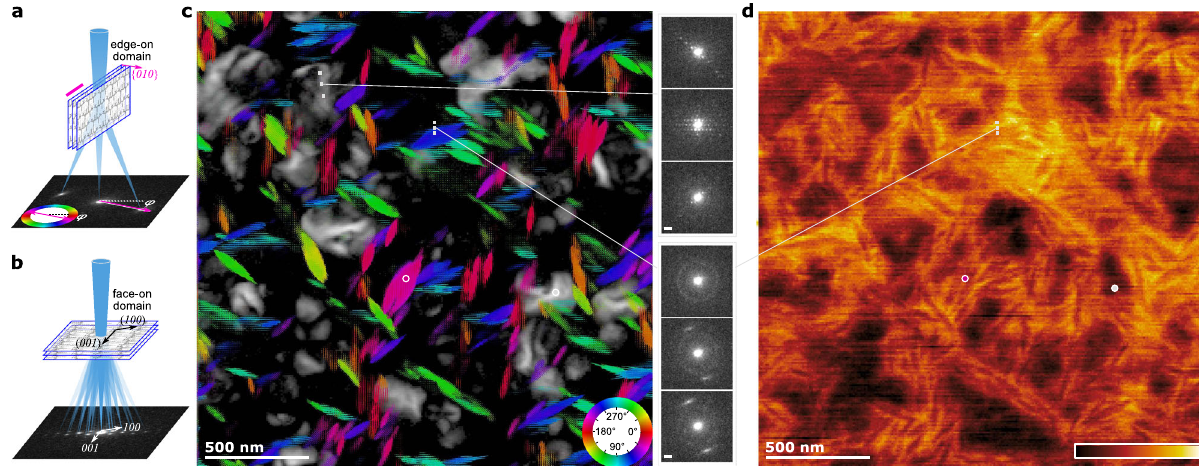
Fig. 4 Visualization of the orientation of donor nano-crystallites and distribution of acceptor. Scheme a uses a color wheel method to encode the edge- on domain orientation at a probed location; b demonstrates our ability to determine the grain orientation of the face-on domains. c Visualization of the whole scanned fi eld of view. Insets on the right (scale bars: 2 mrad) are raw diffraction patterns extracted from the white dots. d Mapping of acceptor distribution using virtual annual aperture including only the angular range of PC 71 BM in each diffraction pattern (cf. Fig. 3b), the mapping is shown in “ black body ” color representation i.e., brighter means higher diffraction signals of PC 71 BM.